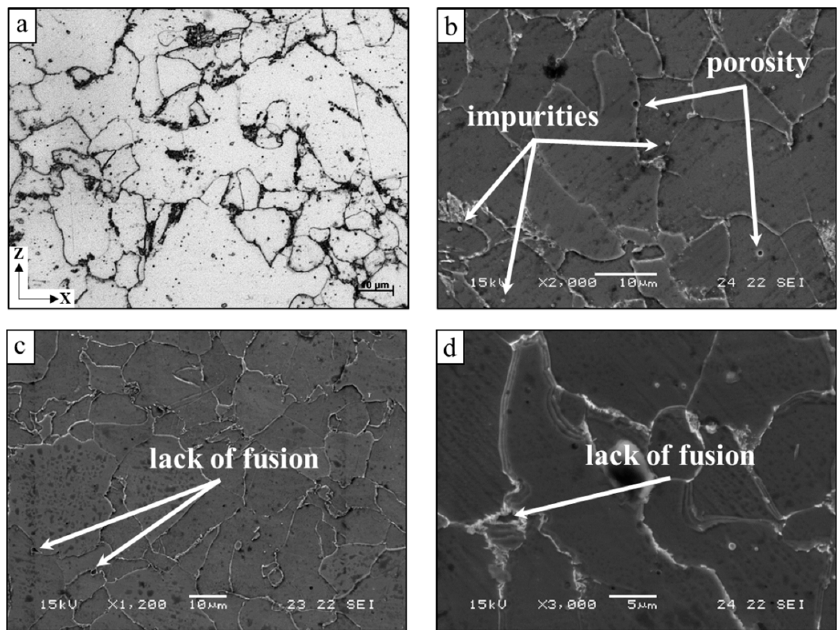
Figure 1. Typical microstructures of additively manufactured ER70S-6 alloy in the XZ plane: ( a ) optical microscopy; ( b – d ) scanning electron microscopy.